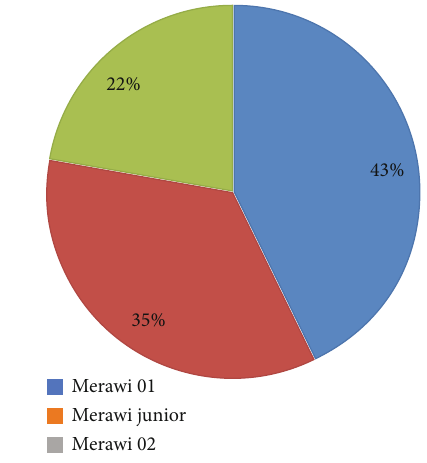
Figure 1: Proportion of participants from the three